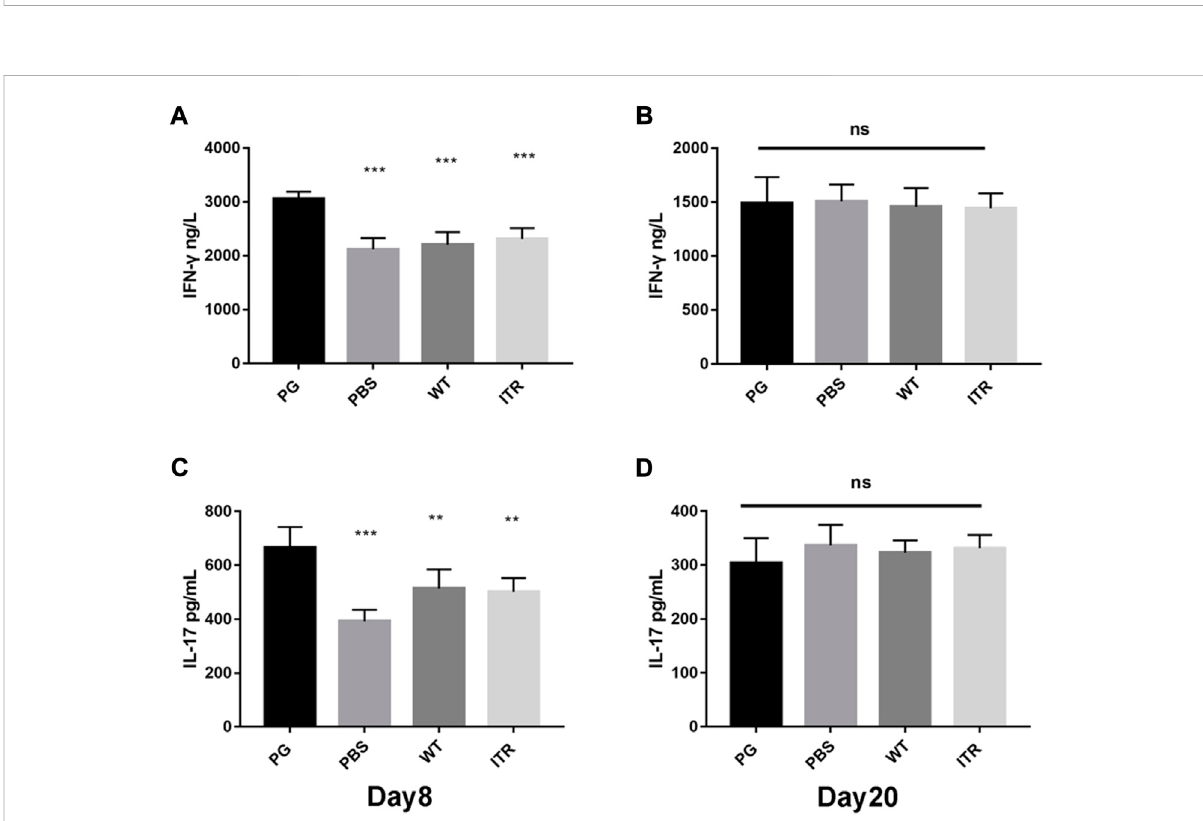
FIGURE 7 IFN- γ andIL-17 levels after PGtreatmentinmice. (A,B) Changein IFN- γ levels inmice on days 8and 20 after S.globosa infection. (C,D) Change in IL-17 levels in mice on days 8 and 20 after S. globosa infection. Compared to thelevels in mice from the PG group, *** p < 0.001, ** p < 0.01, ns: no signi fi cance. Results shown are representative of three independent experiments. WT: wild-type phage injection; ITR: itraconazole injection; PG: phage-GK